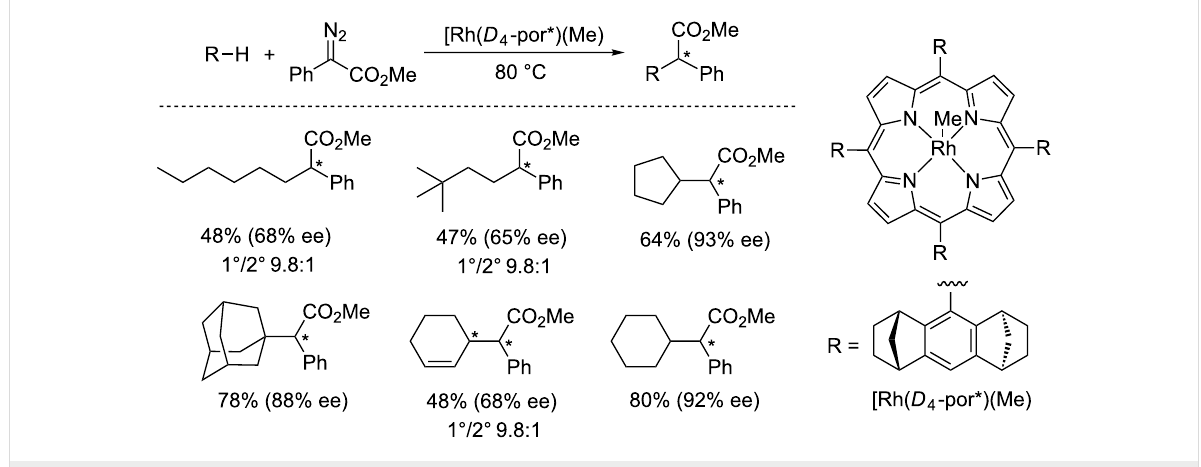
and alkane C(sp 3 )–H bonds afforded the insertion products in up to 80% yield and with up to 93%